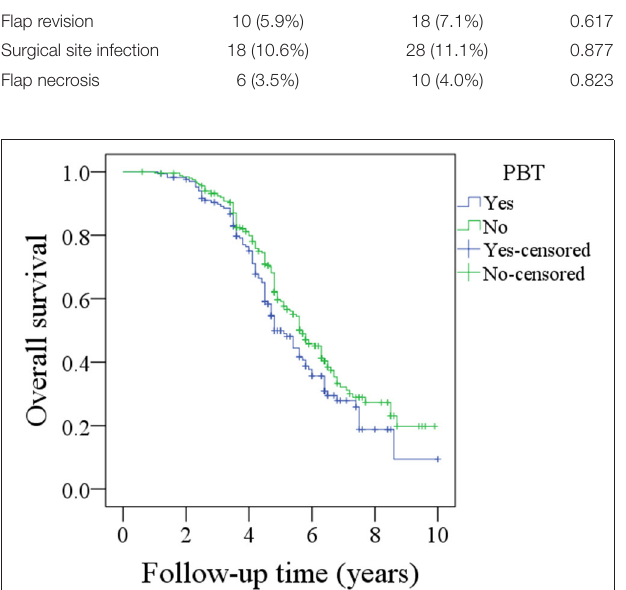
FIGURE 1 | Comparison of overall survival between patients with and without perioperative blood transfusion (PBT) ( p = 0.041).